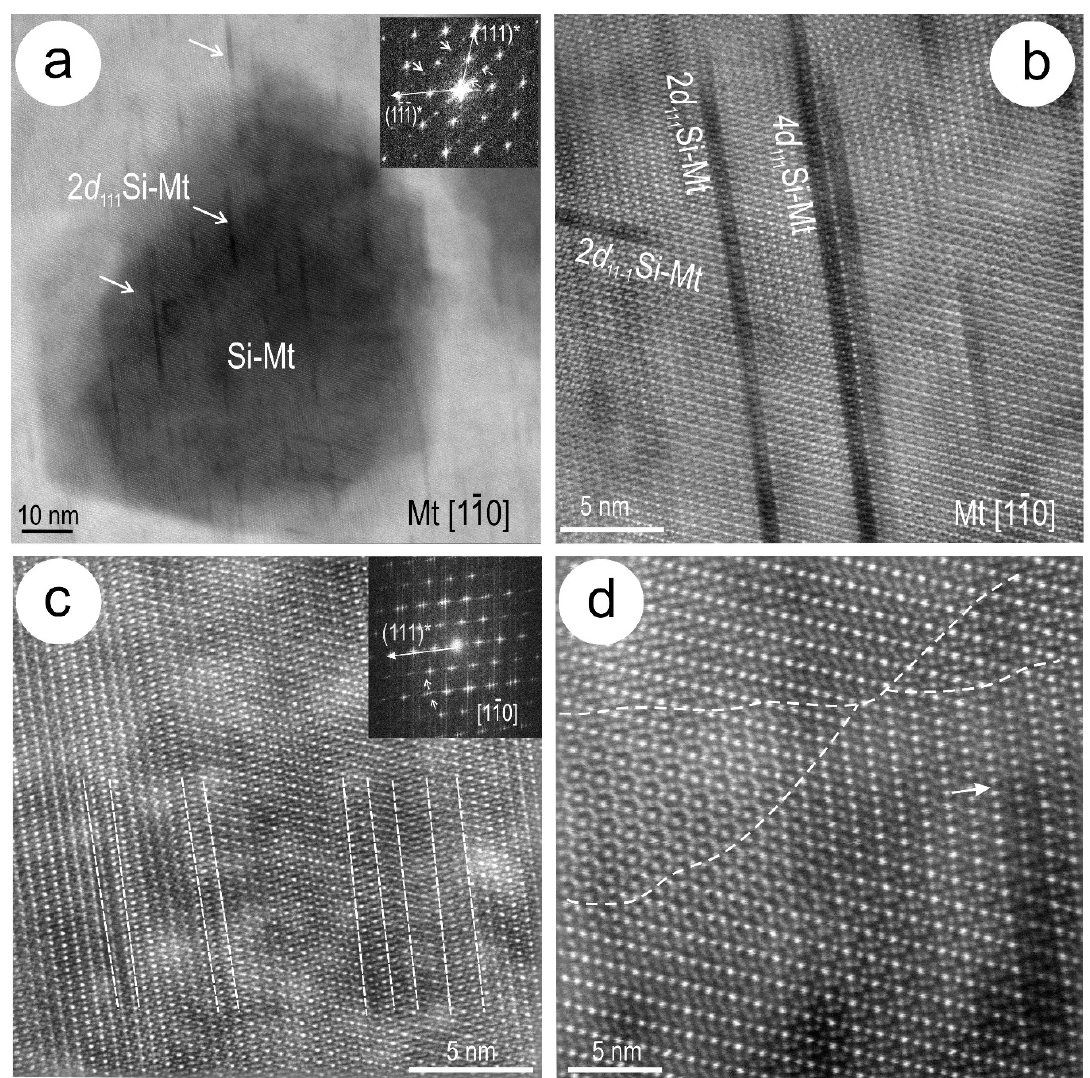
(cid:104) (cid:105) 110 directions 111